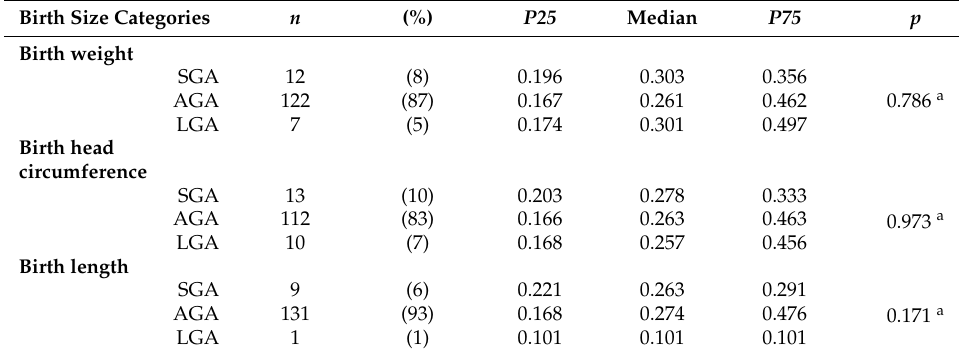
Table 6. Maternal first trimester urinary 3-PBA levels and newborn